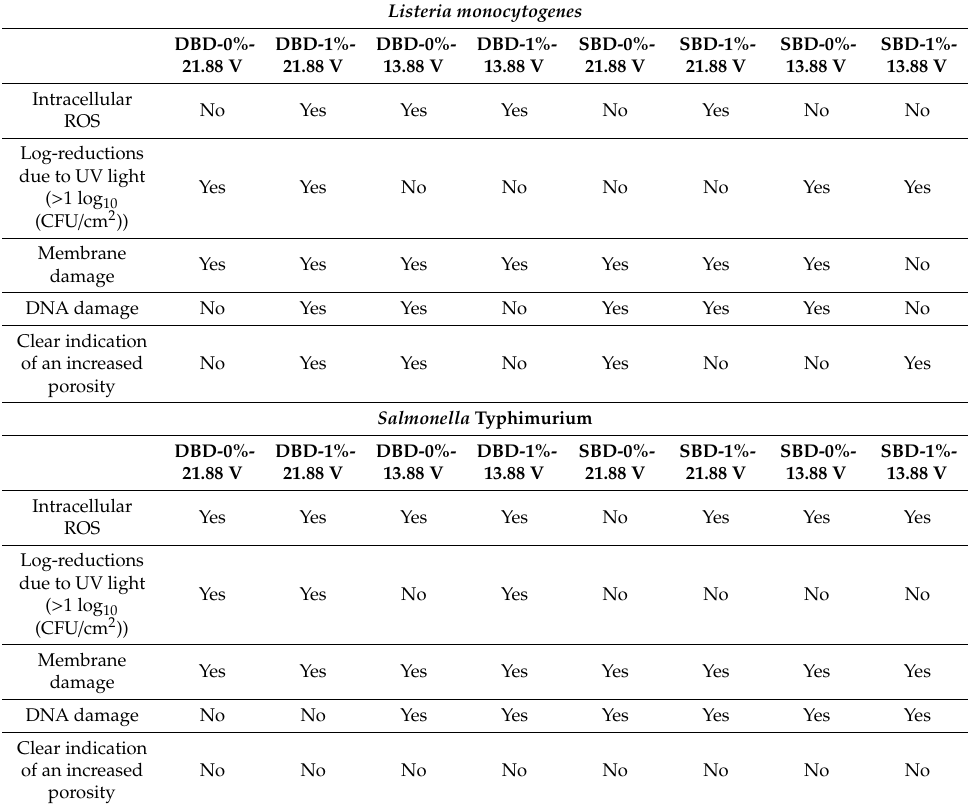
Table 3. Summary table indicating whether the CAP inactivation mechanism for both biofilm forming species was (partially) due to (i) the generation of intracellular ROS, (ii) the presence of UV light, (iii) leakage of the membrane, and / or (iv) DNA damage. In addition, it was also indicated whether CAP treatment resulted in an increased porosity of the